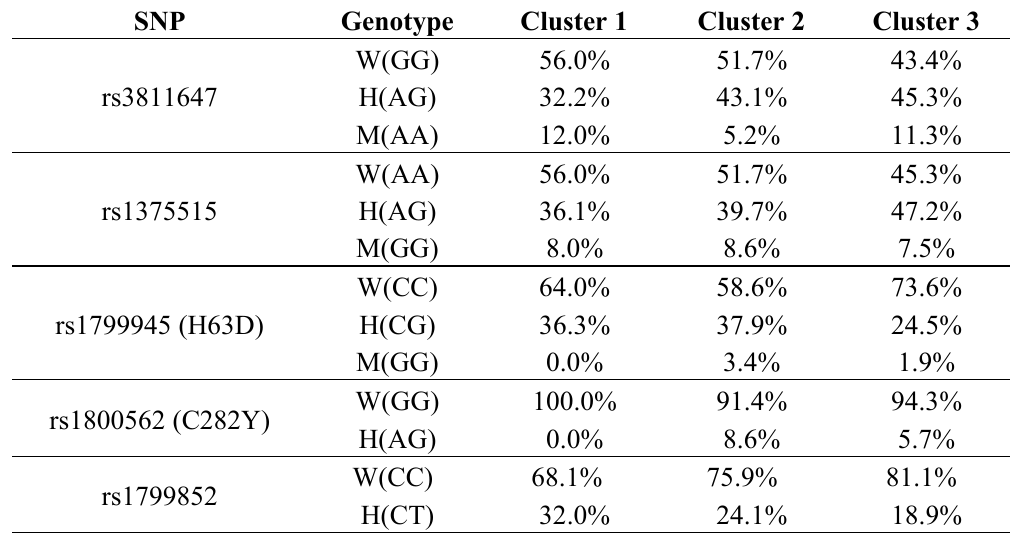
Table 4. Genotype frequencies according to the